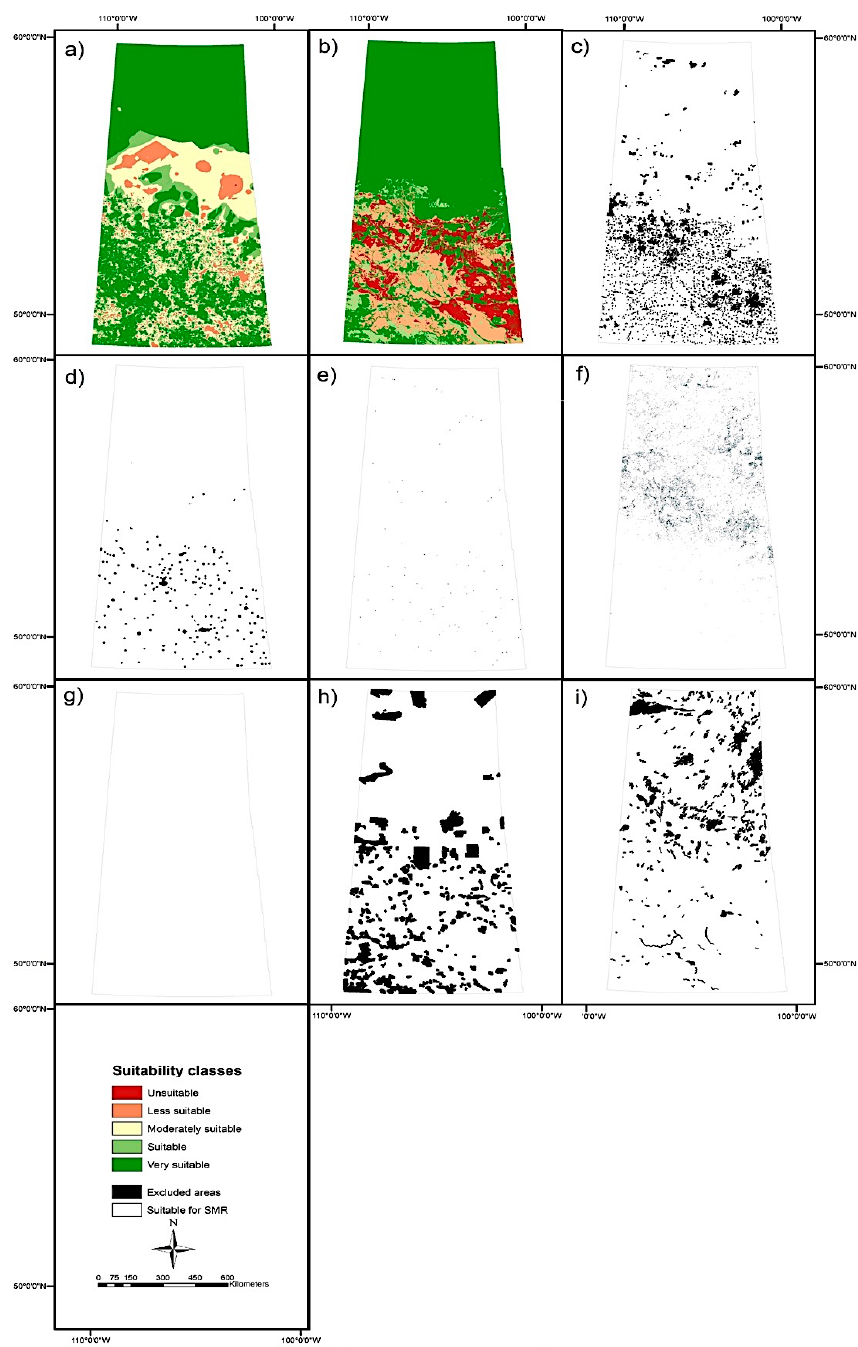
Figure 6. Restriction criteria maps: ( a ) Groundwater, ( b ) agriculture, ( c ) land use, ( d ) population density, ( e ) airports, ( f ) wetlands, ( g ) slope, ( h ) protected areas, and ( i ) flooding areas .